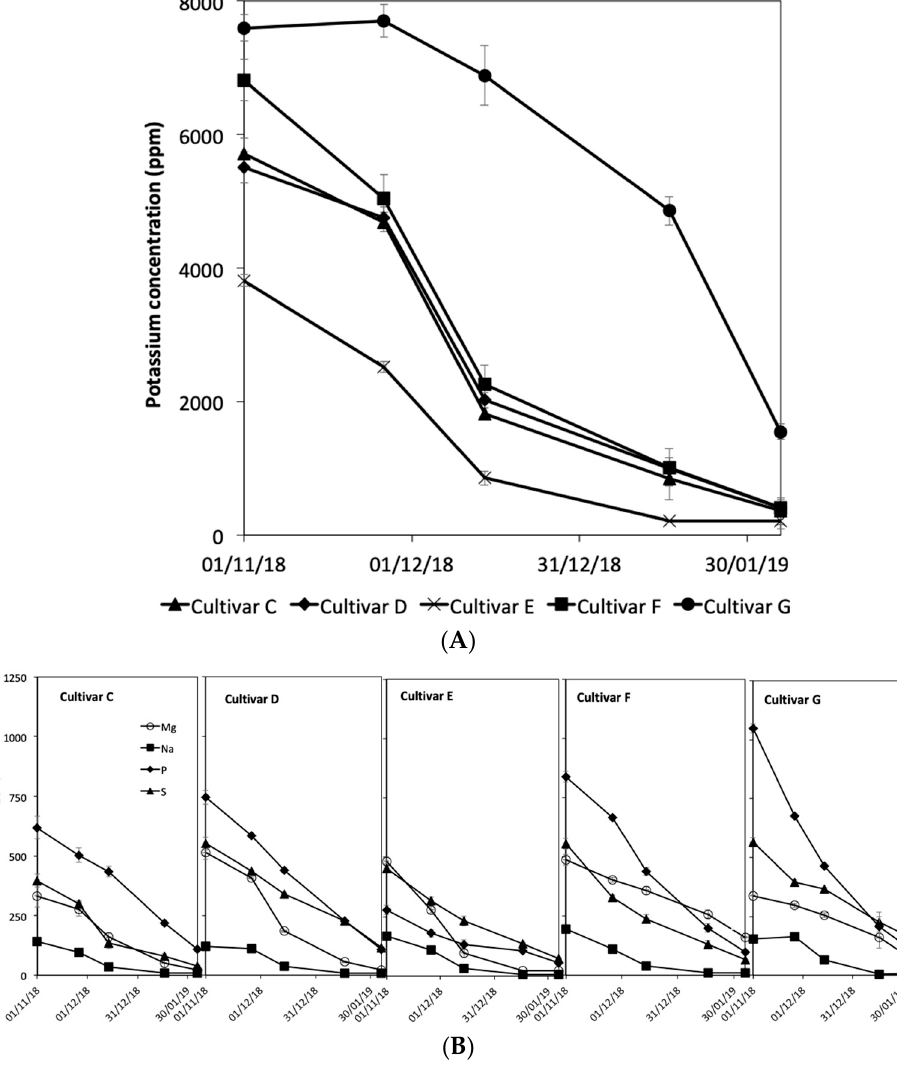
Figure 5. Elemental composition of potassium ( A ), magnesium, sodium, phosphorus and sulphur ( B ) (ppm) of Miscanthus cultivars harvested at specific time-points. Data representative of triplicate values. Harvest dates are 1 November 2018, 20 November 2018, 14 December 2018, 16 January 2019 and 5 February